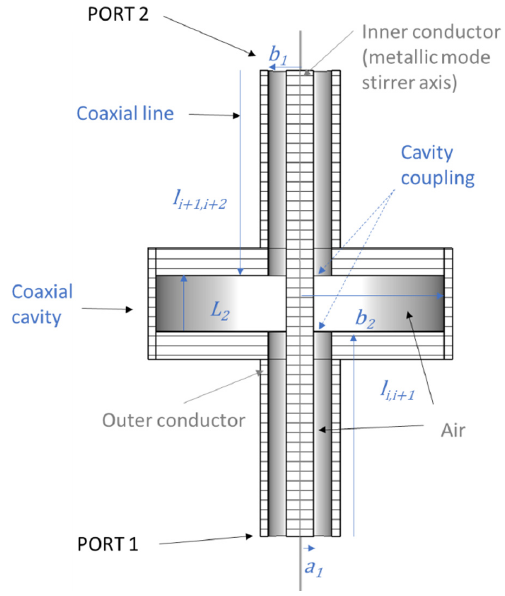
Figure 2. Two-port coaxial cavity employed as a bandstop filter resonator.